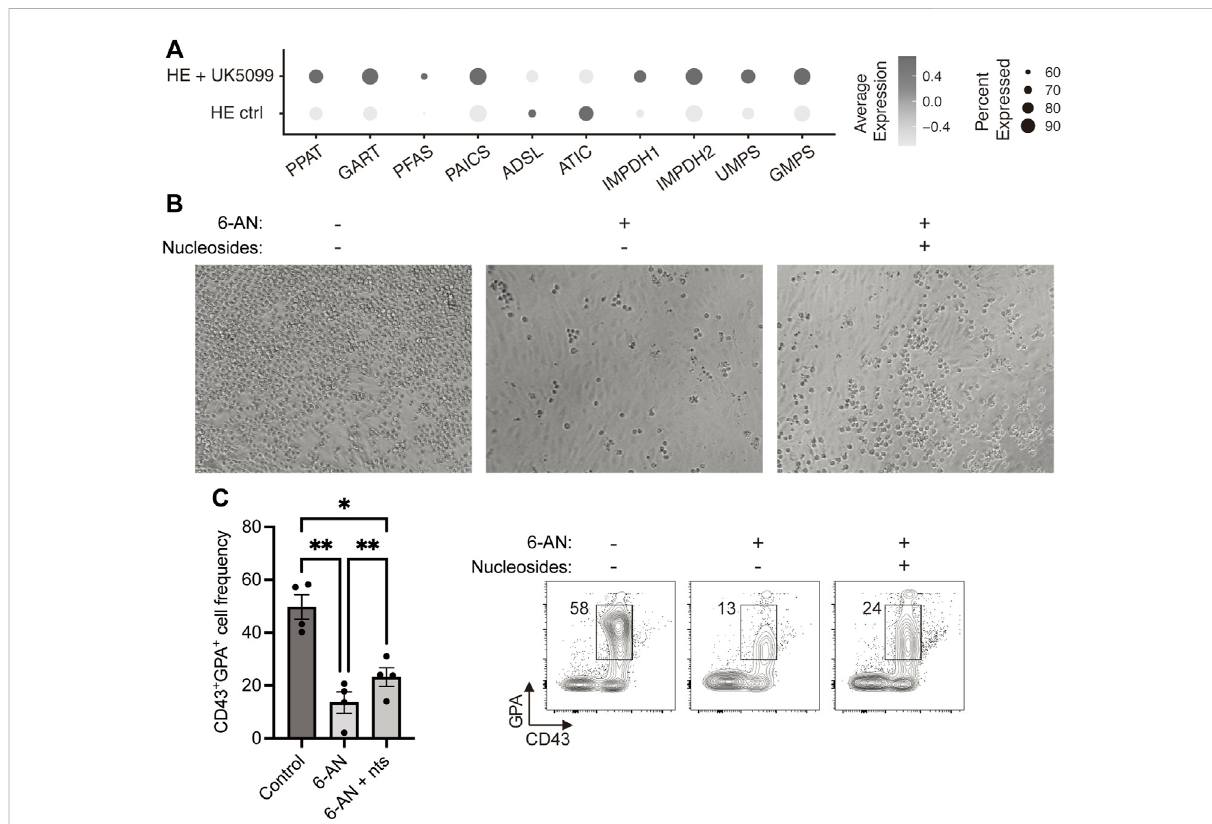
FIGURE 2 Nucleosides partially rescue 6-AN-mediated block in HE-derived erythroid differentiation. (A) Dot plots show expression levels of nucleotide biosynthesis pathway enzymes for HE ctrl and HE + UK5099 in hematopoietic clusters from our previously published dataset, as detected by scRNAseq and based on percent expressed (dot size) and average level of expression (color intensity). (B,C) iPSC-derived HE cells were subcultured with or without 25 µM 6-AN and with or without nucleosides (nts) for 6 days. Representative bright fi eld pictures of the wells (B) and representative plots and bar graphs showing CD43 + GPA + cell frequency ± SEM at day 6 (C) are presented ( n = 3 with 1-2 technical replicates, paired t -tests). Culture media was changed every 2 days and inhibitors were added at every media change. ns, not signi fi cant, * p < 0.05, ** p < 0.01, **** p <